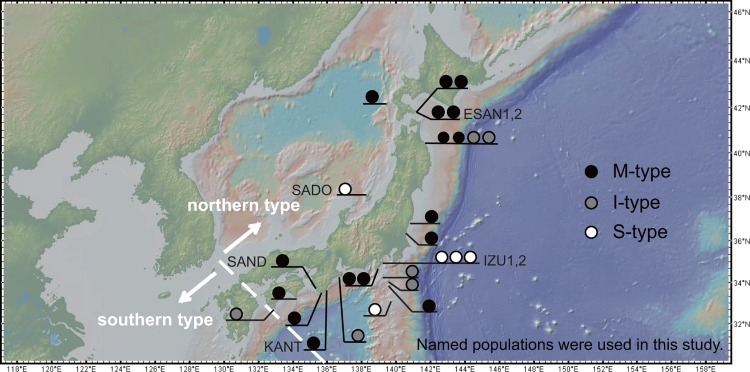
Distribution of northern and southern types of diploid sexual Cyrtomiun falcatum in Japan based on Matsumoto (2003) [11], and sampling locations of 7 populations examined in this study.Dashed line is the boundary of the northern and southern type’s distributional range. This map was drawn by GeoMapApp (http://www.geomapapp.org/). Locations of the M-type (black circle), the I-type (gray circle) and the S-type (open circle) sporophyte individuals identified by Matsumoto (2003) [11] are shown.